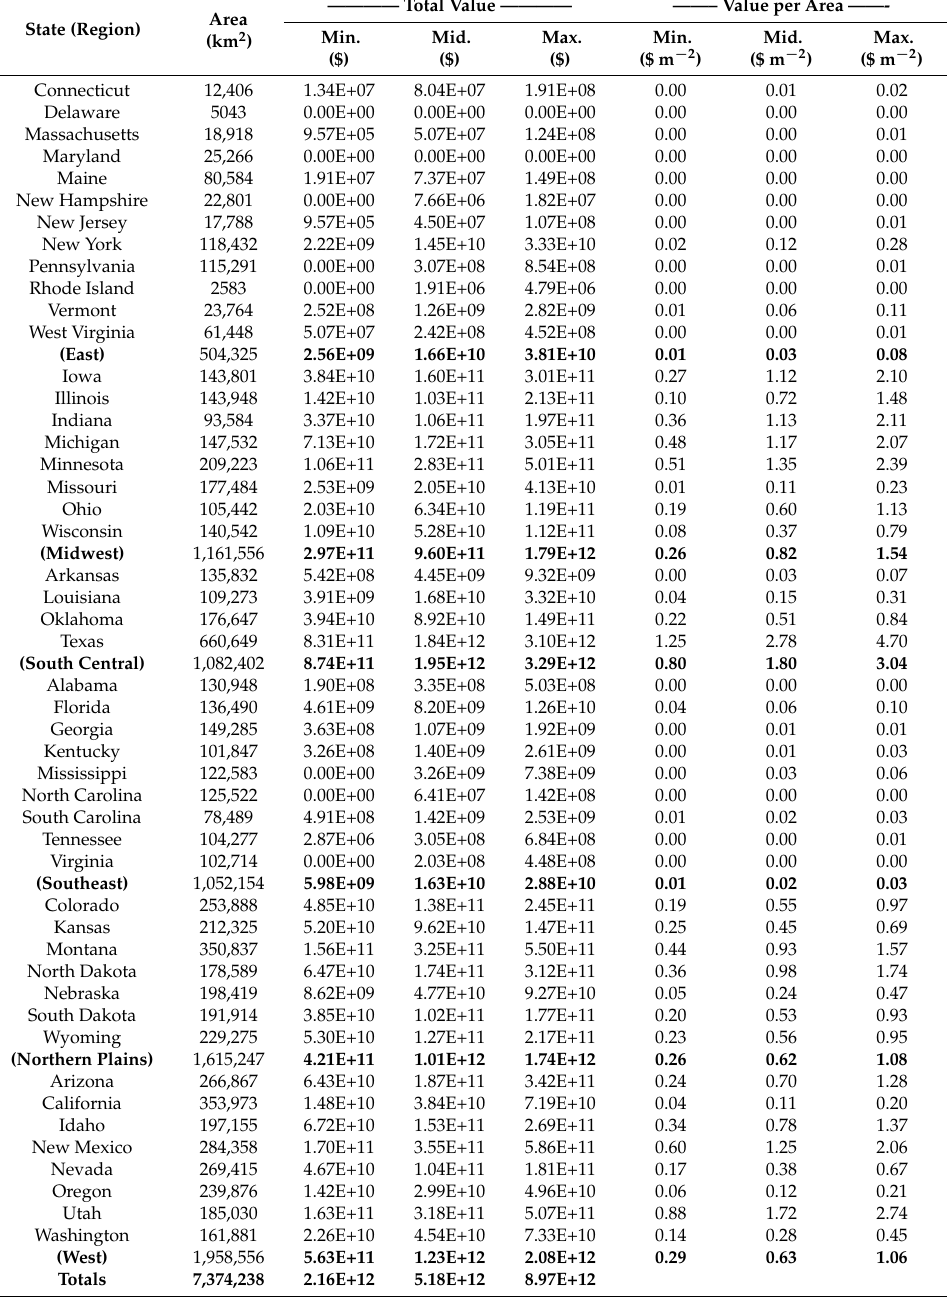
Table 4. Total SIC value and area-averaged value (rankings) of each state (region) based on [9] and